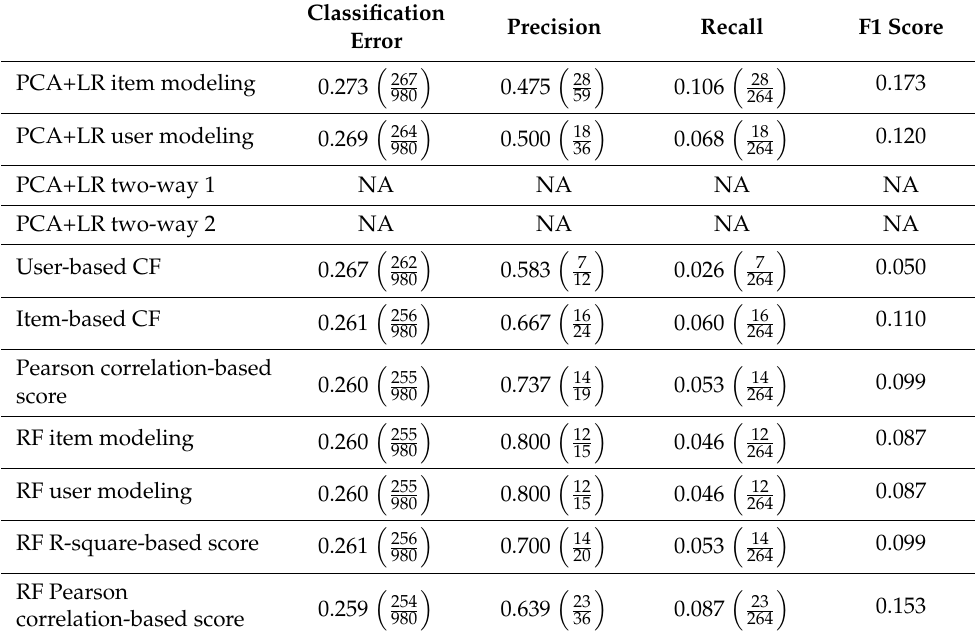
Table 2. Prediction performance